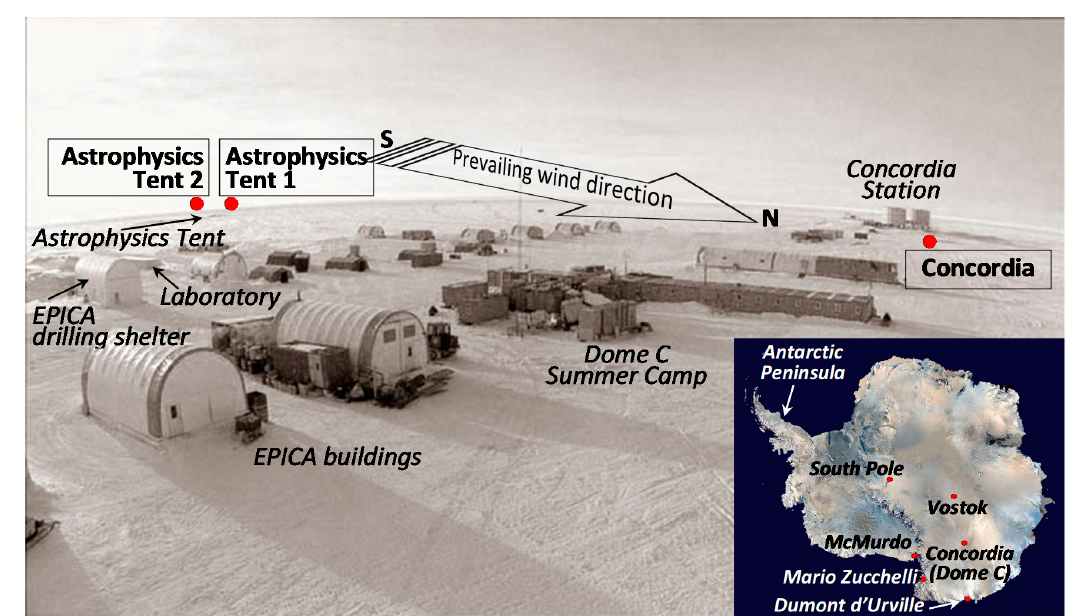
Figure 7. View of the Dome C area through a wide-angle panoramic photo (with Concordia Station in the background and Dome C-Summer Camp in the foreground). The insertion shows the location of Dome C on a map of Antarctica. The photo shows also the sampling points, big red circles (Concordia, CS; Astrophysics Tent 1, AT1; Astrophysics Tent 2, AT2) and the prevailing wind direction (from south to north) referred to the sampling period.